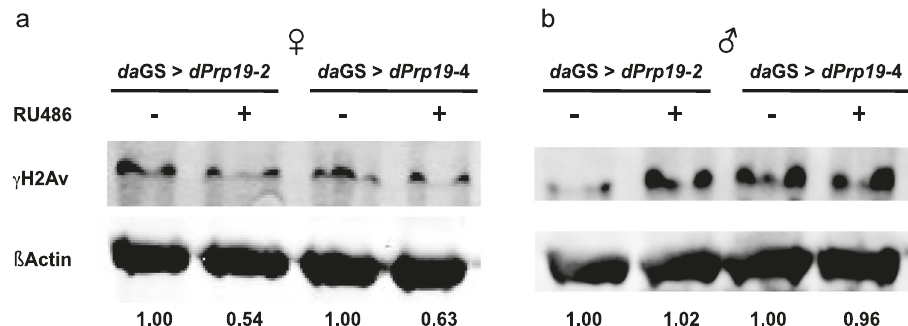
Fig. 3 Overexpression of dPrp19 decreases γ H2Av as marker for DNA double-strand breaks in females but not males. Overexpression of dPrp19 ( daGS-Gal4 > UAS-dPrp19-2/4 ) induced by 300 µg/ml RU486 decreases the accumulation of γ H2Av by approximately 40 – 50% in female fl ies a as compared to the uninduced controls. In males b , we did not observe an effect of dPrp19 induction on DNA damage levels. Numbers represent protein signals of γ H2Av normalized to β Actin. The blot shown is representative; qualitatively identical results were obtained with at least two biological and two technical